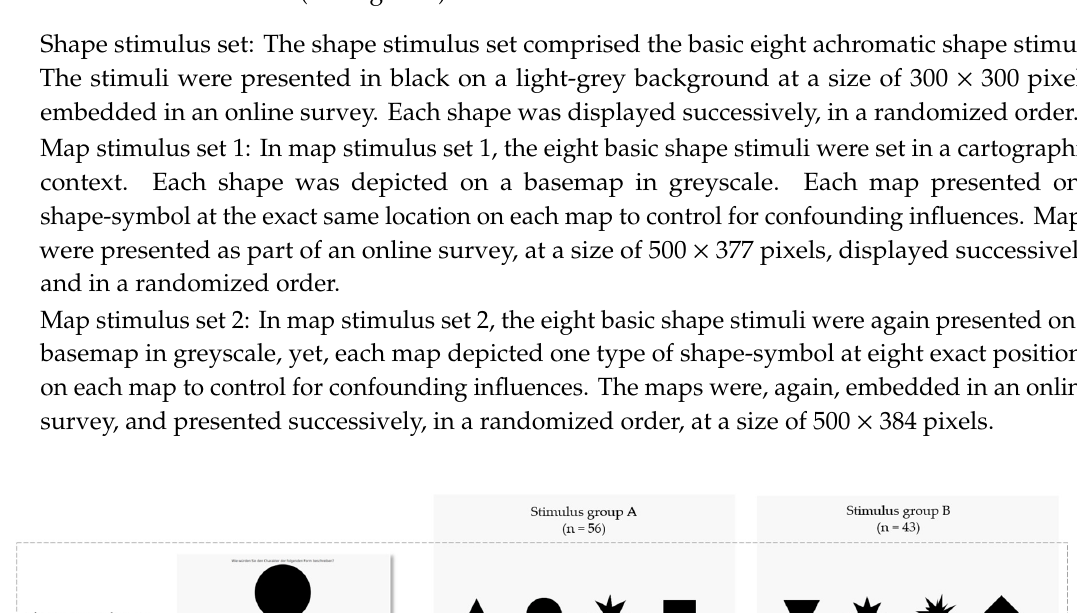
Map stimulus set 2: In map stimulus set 2, the eight basic shape stimuli were again presented on a basemap in greyscale, yet, each map depicted one type of shape-symbol at eight exact positions on each map to control for confounding influences. The maps were, again, embedded in an online survey, and presented successively, in a randomized order, at a size of 500 × 384 pixels.